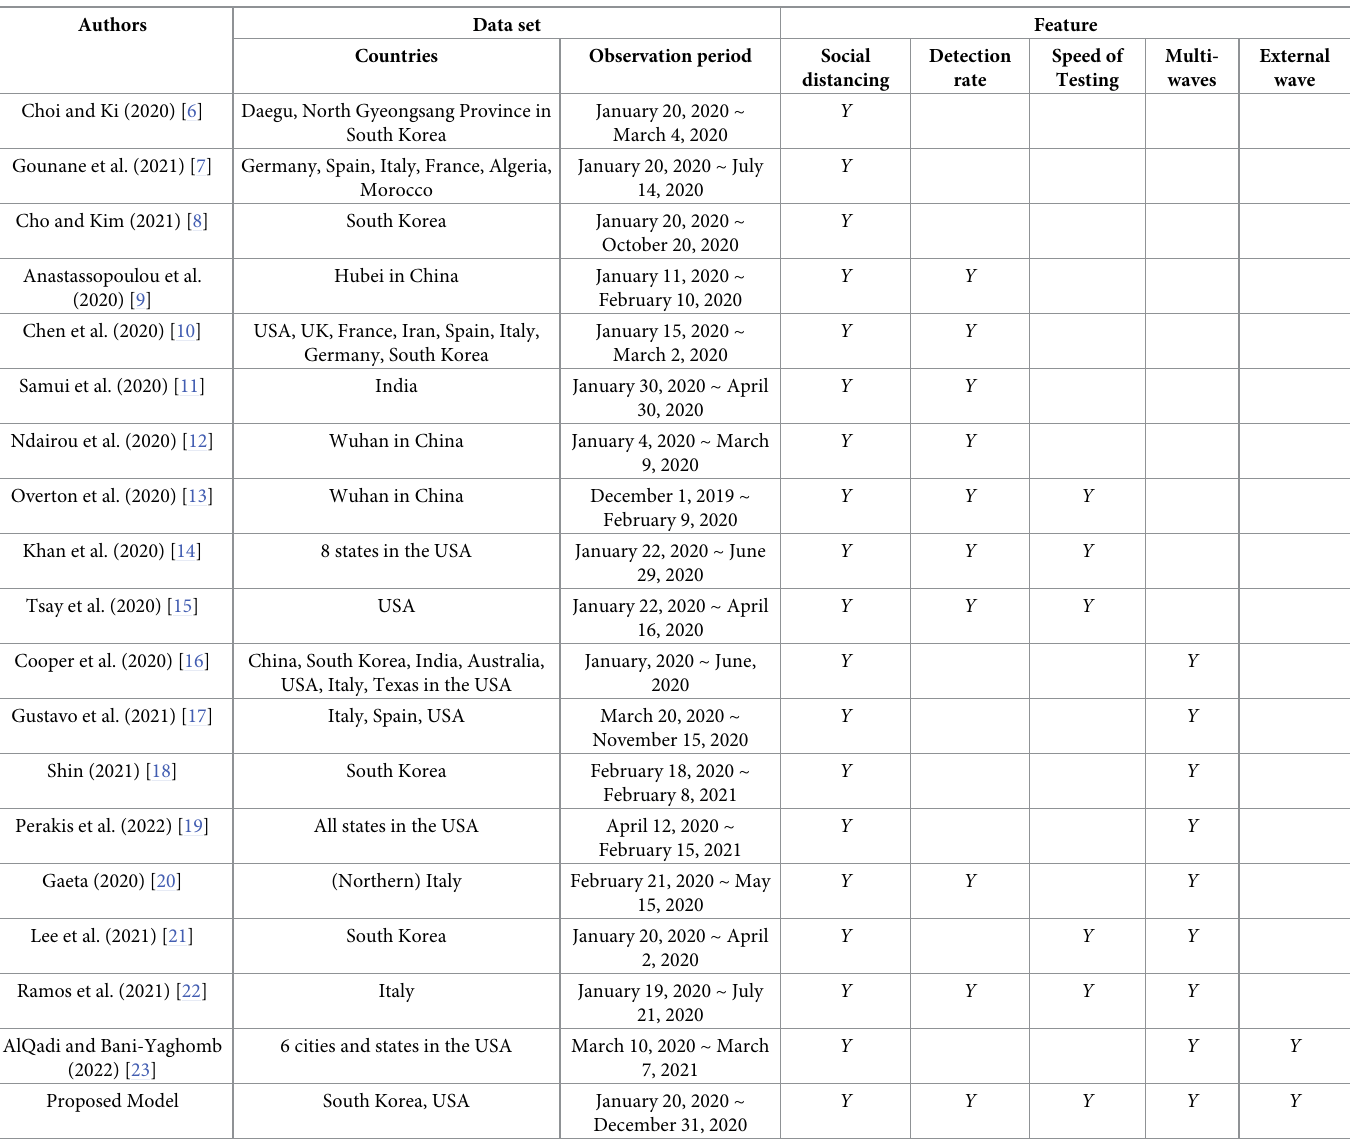
Table 1. Description of SIR type models for COVID-19.